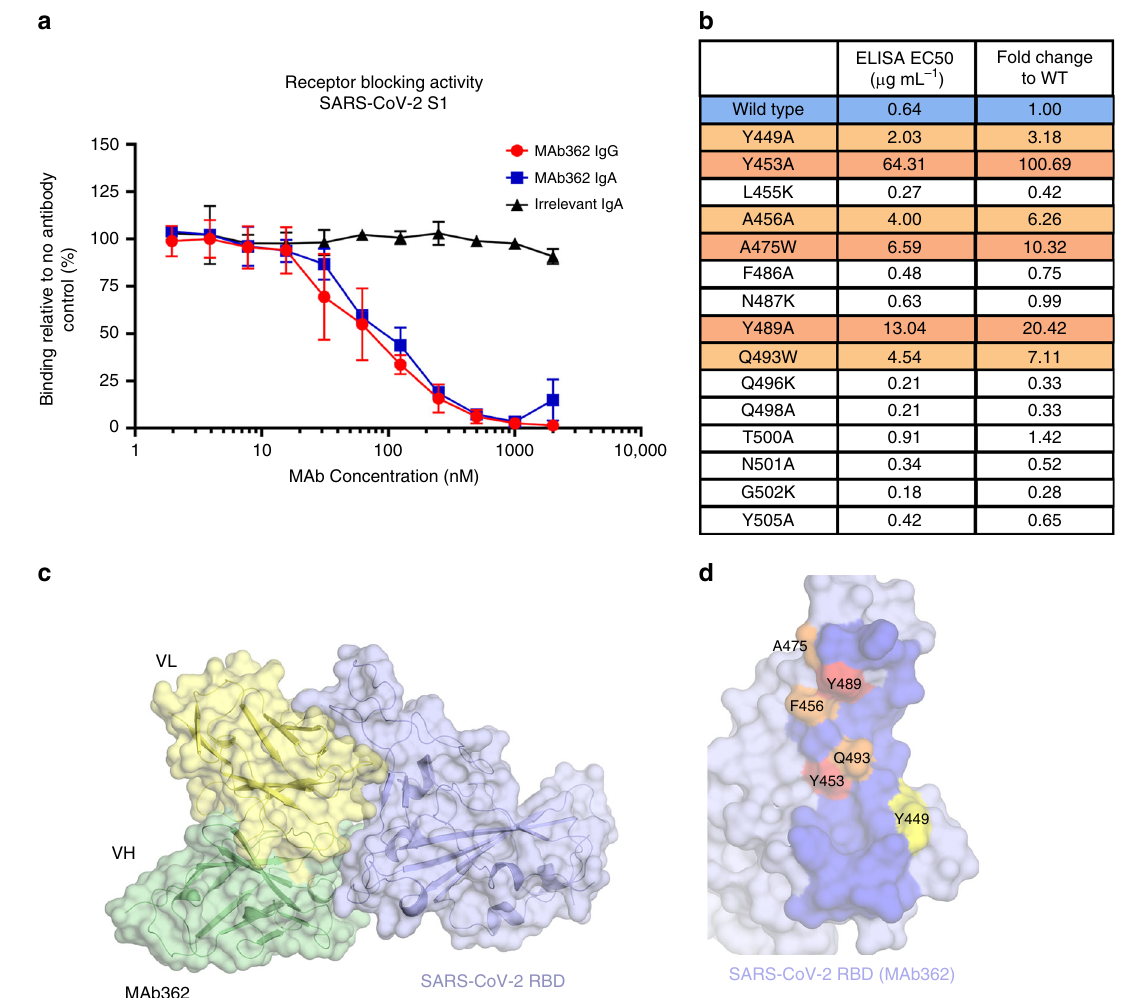
Fig. 2 Mutationally guided molecular modeling of MAb362 binding to RBD. a SARS-CoV-2 S1 was pre-incubated with MAb362 IgG (red circles) and IgA (blue squares) ranging from ~2 to 2000 nM. Both MAb362 isotypes demonstrated concentration-dependent inhibition of SARS-CoV-2 RBD binding to Vero E6 cells at concentrations >30 nM. Data are plotted as the mean ± s.d. from n = 3 independent experiments. b Mutational scanning was performed to better delineate the binding surface. Key residues were mutated and expressed as recombinant proteins. Identi fi ed critical residues (orange) were experimental con fi rmed by shifts in EC 50 values for MAb362 binding in ELISA relative to wild-type RBD (blue). EC 50 values calculated from n = 3 independent experiments. c Surface representation of the predicted molecular model of MAb362 SARS-CoV-2 RBD complex; the light chain of MAb362 (light yellow), the heavy chain (green), and the SARS-CoV-2 RBD (violet). d The predicted binding interface on SARS-CoV-2 RBD with MAb362. The residues identi fi ed by mutagenesis from b are labeled and colored according to in fl uence degree; red represents strongest defects, orange for medium defects and yellow for subtle defects. Source data are provided as a Source Data fi le a , b